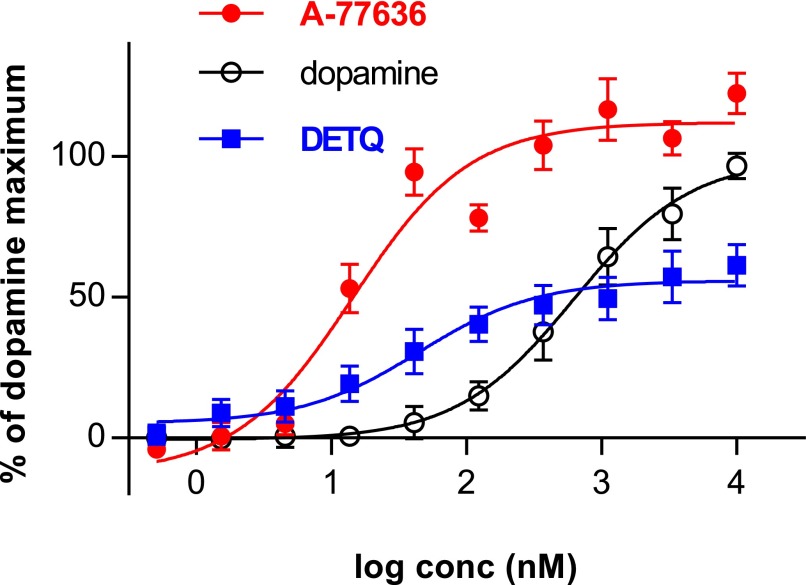
D1 receptor internalization in response to DETQ and A-77636. The values are mean ± S.E., n = 6. The best-fit values from a three-parameter model (Langmuir isotherm) are DETQ: bottom 5.0% ± 4.2%, top 55.8% ± 3.7%, EC50 44.6 ± 21.6 nM; A-77636 bottom −12.8% ± 6.7%, top 112.0% ± 3.9%, EC50 14.5 ± 3.7 nM; dopamine bottom −0.3% ± 1.2%, top 99.4 ± 2.7%, EC50 627 ± 69 nM. For DETQ and A-77636, 0% is defined as the response to an EC20 of dopamine, and 100% is defined as the maximum dopamine response; for dopamine 0% is the basal internalization, and 100% is the maximum dopamine response.